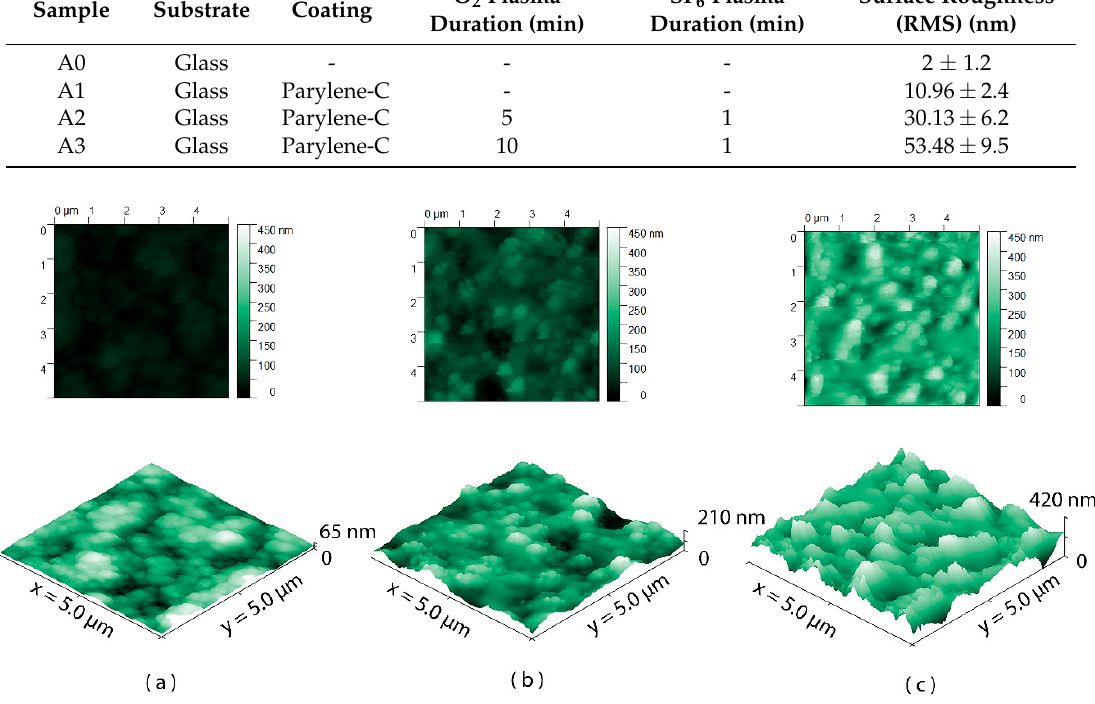
Figure 4. Atomic Force Microscopy (AFM) scans of ( a ) A1: untreated Parylene-C; ( b ) A2: Parylene-C treated with 5 min O 2 and 1 min SF 6 ; ( c ) A3: Parylene-C treated with 10 min O 2 and 1 min SF 6 .